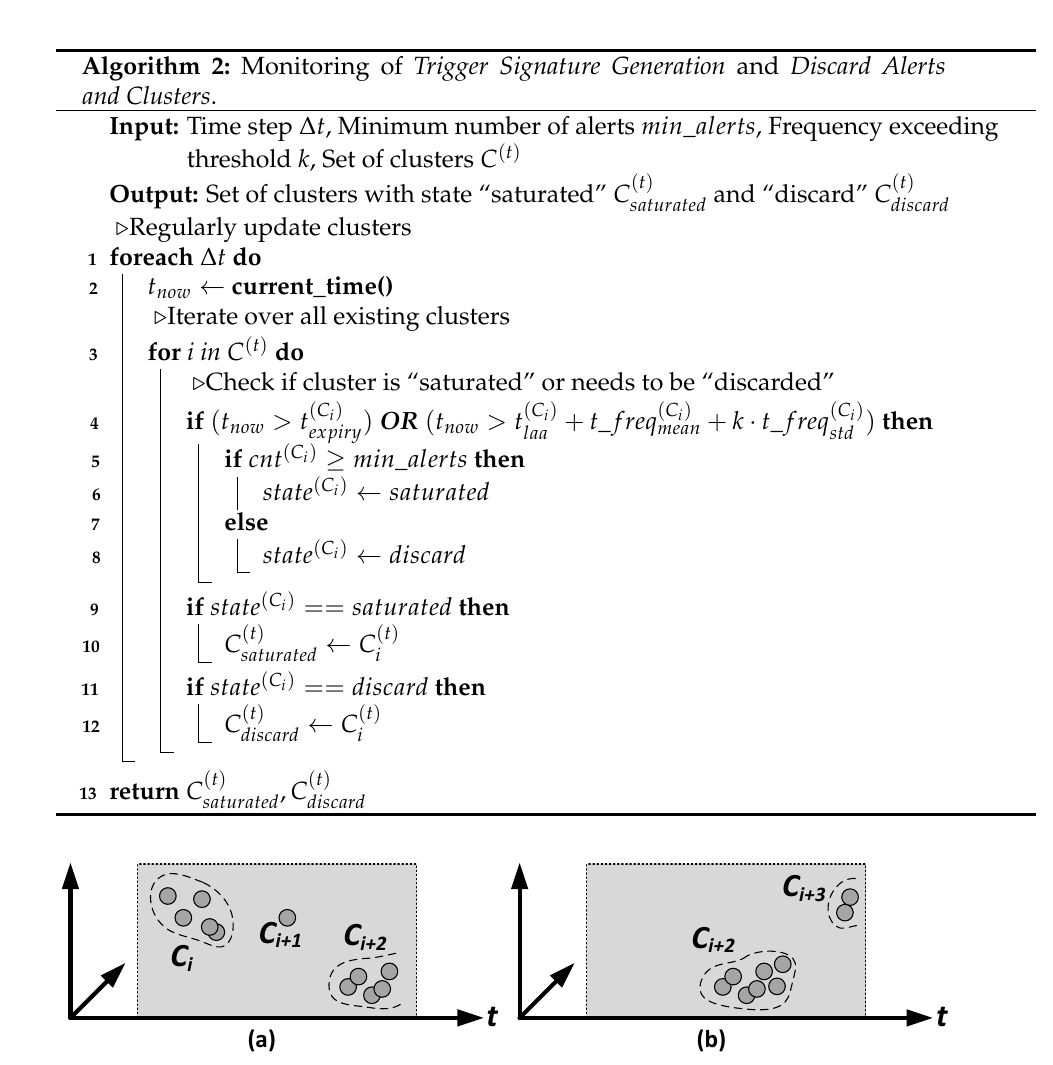
Figure 3. An exemplary scenario of evolving alert clusters for two different observation times ( a , b )—indicated by the frames with gray background—with two hypothetical alert attributes and the timestamp